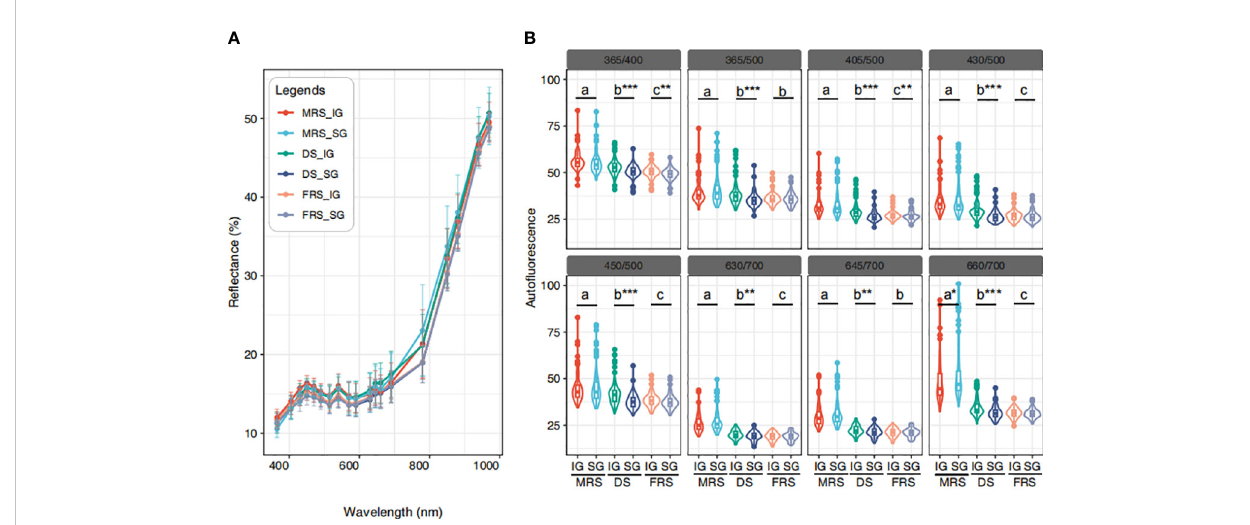
FIGURE 4 Spectral information of Siberian wild rye seeds. (A) Average multispectral re fl ectance of 19 wavelengths. (B) 8 auto fl uorescence wavelengths. The use of different colours was used to indicate differences in grain position at different maturity stages. The Duncan test was used to determine the signi fi cance of differences among maturity stages of Siberian wild rye seeds at the P <0.05 level, as indicated by the use of lowercase letters. In addition, Student ’ s t-test was used to determine the signi fi cance of differences between grain positions within the same maturity period, as indicated by the use of symbols ‘ * ’ , ‘ ** ’ , ‘ *** ’ or the absence of such symbols, respectively, denoting signi fi cance at P <0.05, P <0.01, P <0.001, and non- signi fi cance at P >0.05.